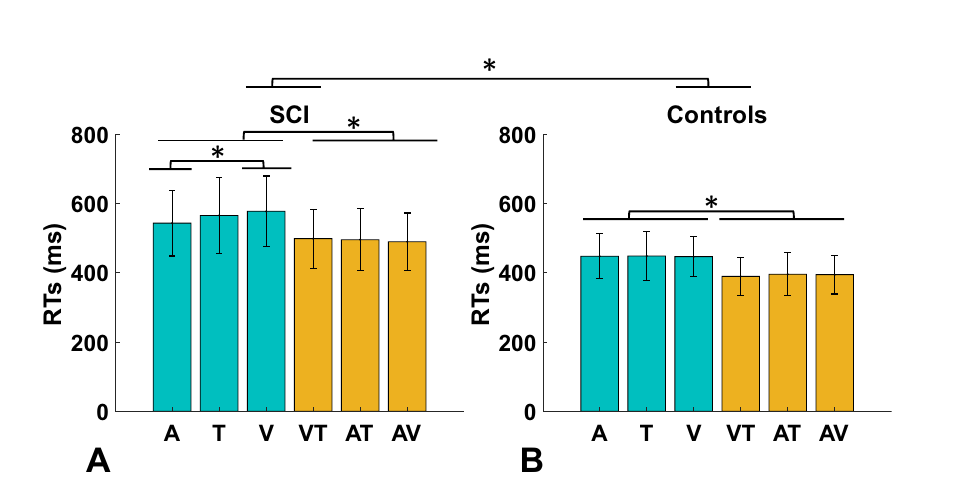
Figure 2. Reaction Times (RTs ) of SCI participants ( A ) and healthy controls ( B ) : Green bars show the unimodal stimuli (Audio, Tactile and Visual), yellow bars show the bimodal stimuli (Visuo-tactile, audio-tactile, and audiovisual). (Error bars indicate the standard deviation; * p <